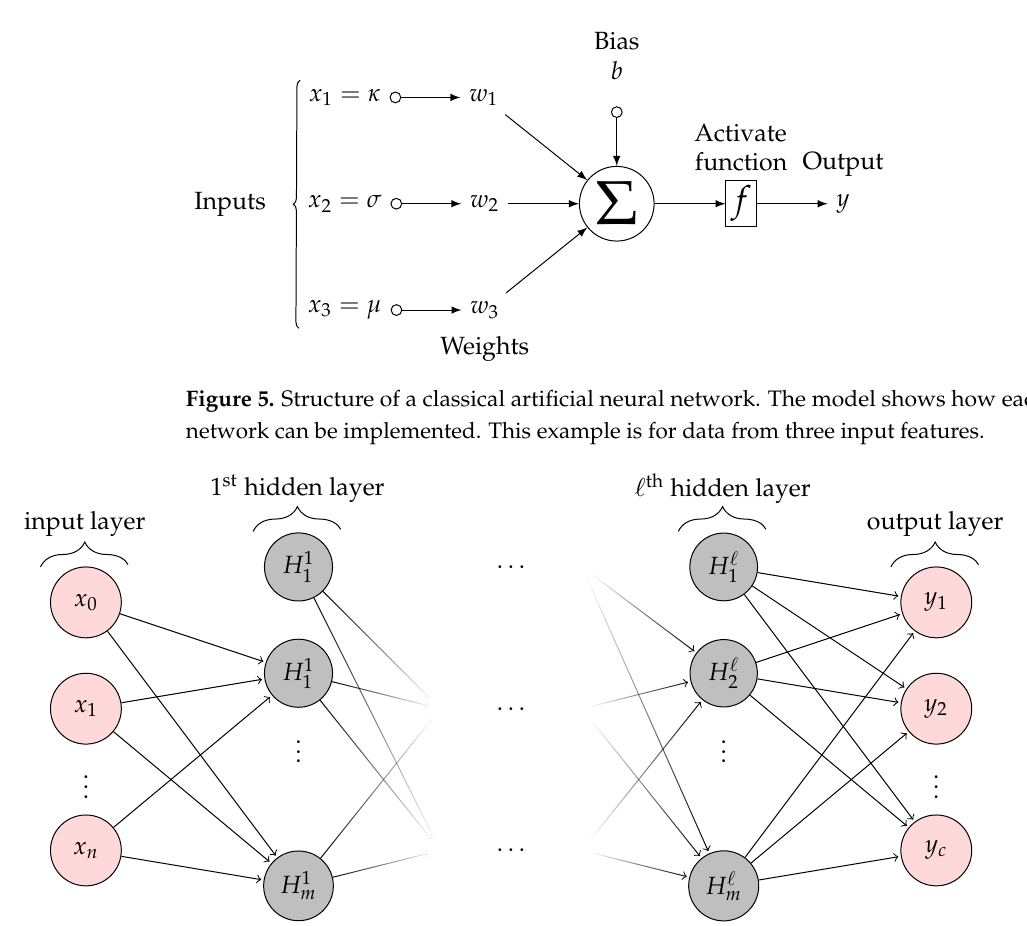
Figure 6. A Topological configuration of a bilayer neural network used only two hidden layers (cid:96) = 2. The input is propagated layer-by-layer toward the output layer, note that the outputs of the neurons from the first neural layer are the inputs of the neurons from the second hidden neural layer. This example is a multilayer-perceptron for x n input features data, (cid:96) th layers, and y c